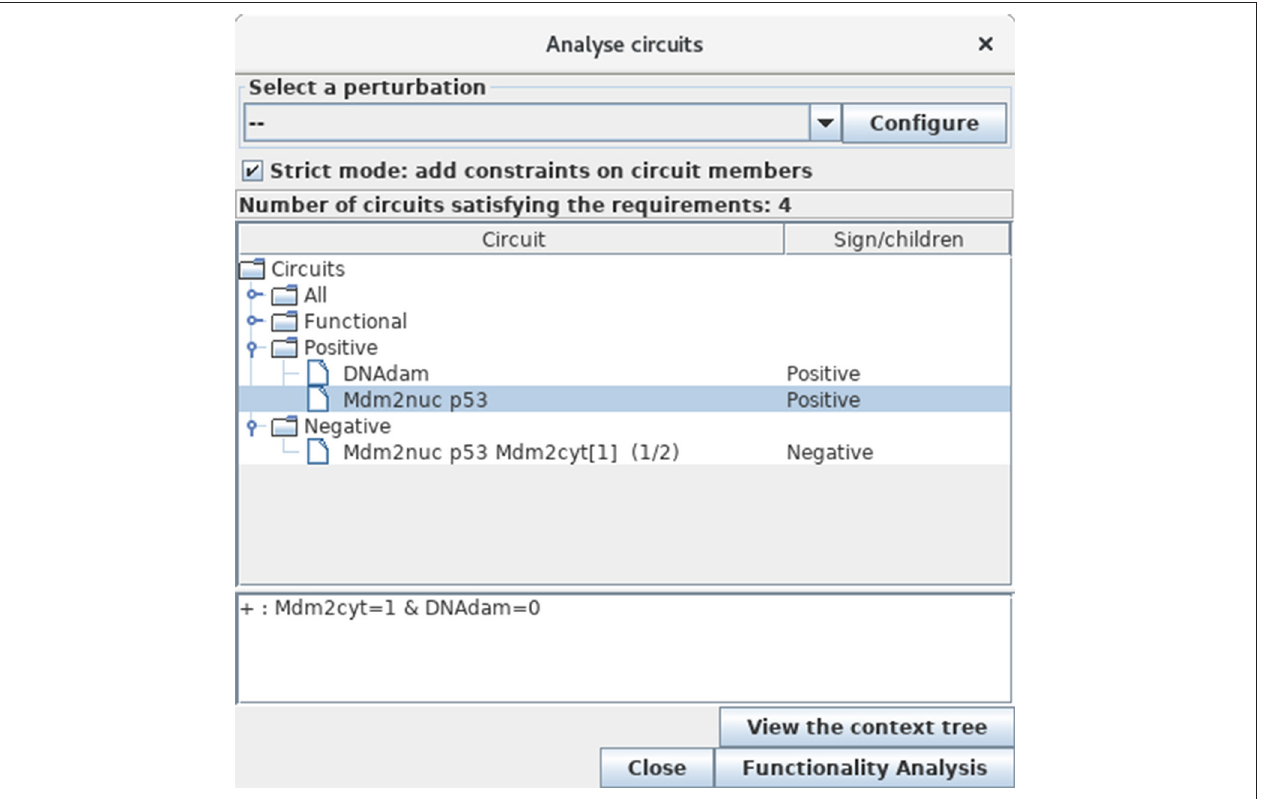
FIGURE 11 | Circuit analysis for the p53-Mdm2 logical model. This window appears after first selecting the Analyse Circuits option of the Tools scrolling menu in the main window, then clicking on the Search Circuits button, and finally launching the Functionality Analysis option. Among the four circuits found in the regulatory graph, three are functional: one is negative, while the other two are positive. The selected circuit (involving p53 and Mdm2nuc) is positive and functional when the level of Mdm2cyt is medium (equal to 1) in the absence of DNA damage (DNAdam =